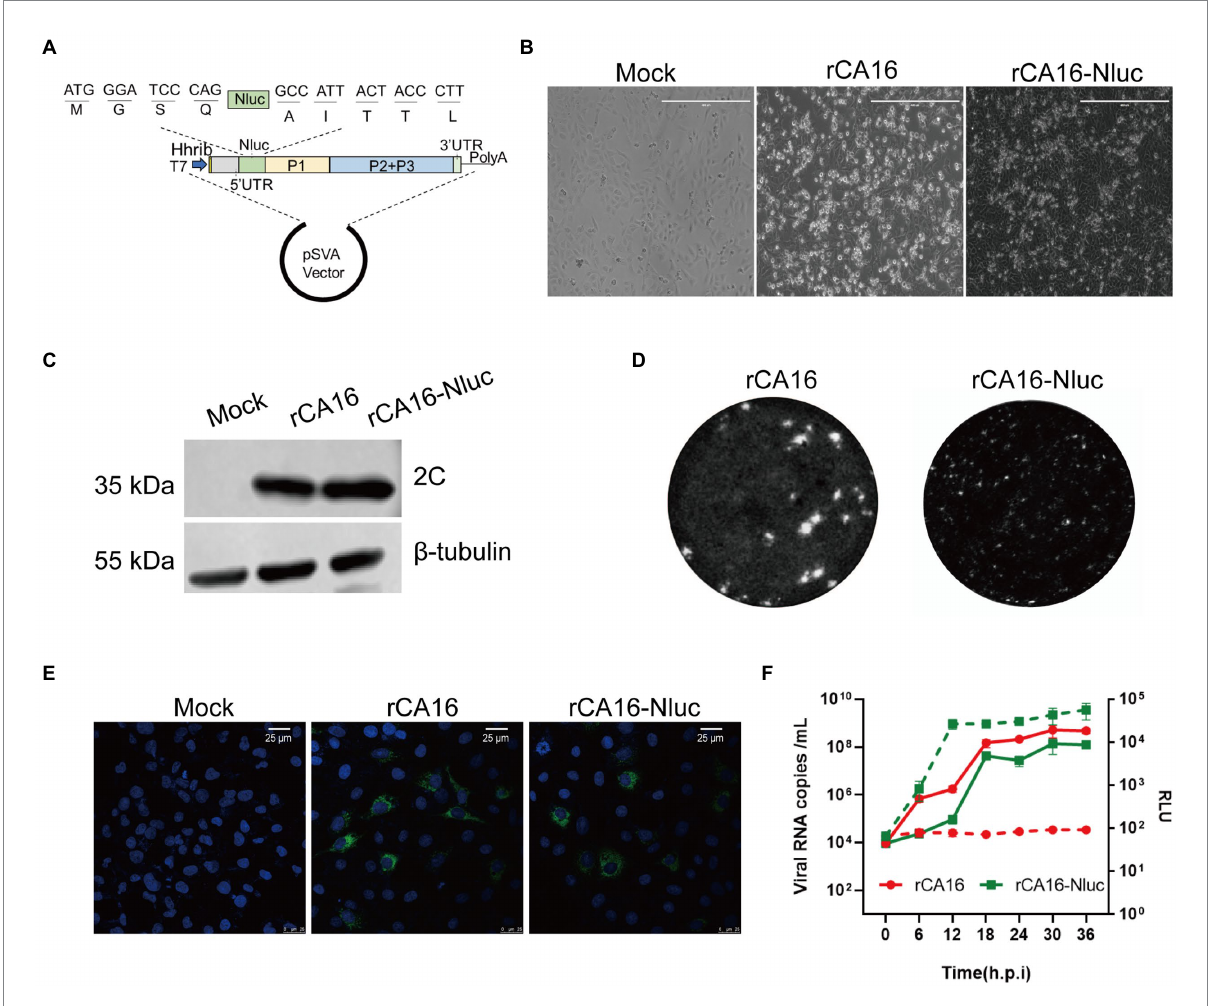
FIGURE 3 Construction and characterization of the rCA16-Nluc infectious clone. (A) The Nluc gene and the 2A proteinase cleavage site (AITTL) were inserted in the rCA16 infectious clone. (B) Vero cells infected with rCA16 and rCA16-Nluc produced the cytopathic effect (CPE) 24 h after